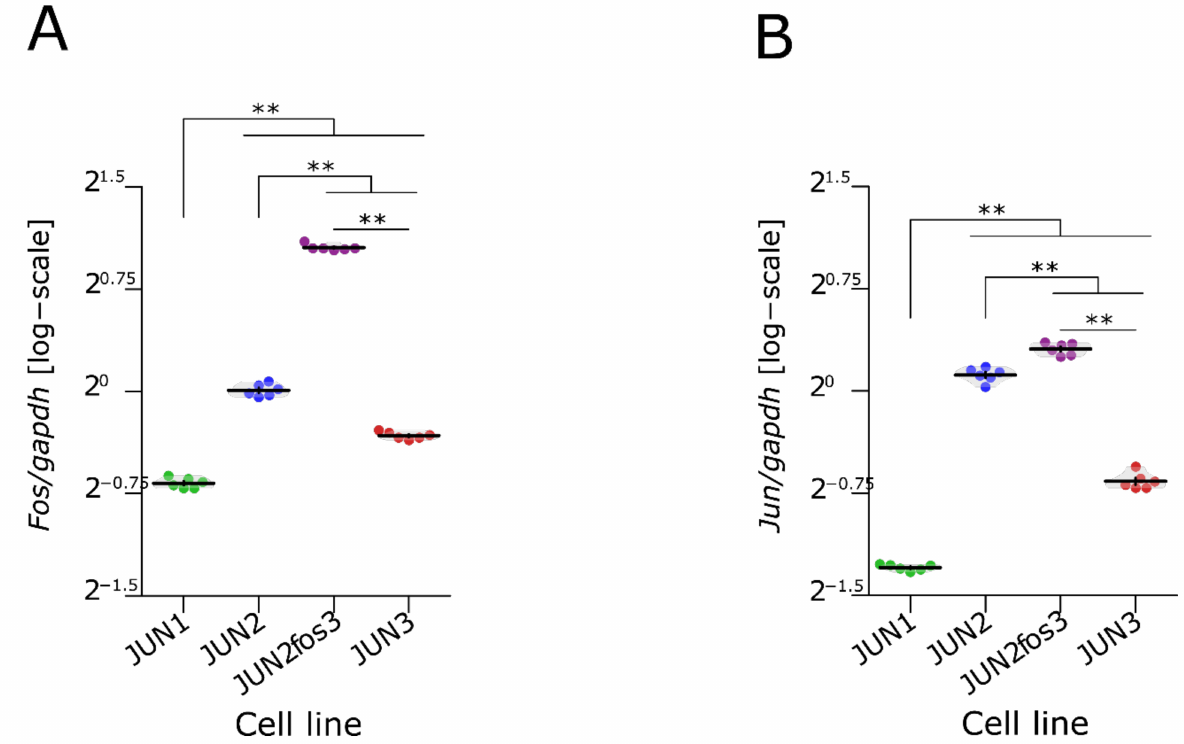
Figure 1. Fos and Jun expression in fibrosarcoma cell lines. ( A , B ) Comparison of jun and fos expression in different JUN- sarcoma cell lines. Results of permutational ANOVA: F 3,20 = 1531, ** p < 0.01 ( jun expression) and F 3,20 = 2948, ** p < 0.01 ( fos expression). See Table S1 for results of contrasts between pairs of lines, their confidence intervals, and exact p -values. Each point represents an individual experiment ( n = 6). Violin plots with means ± SEM are